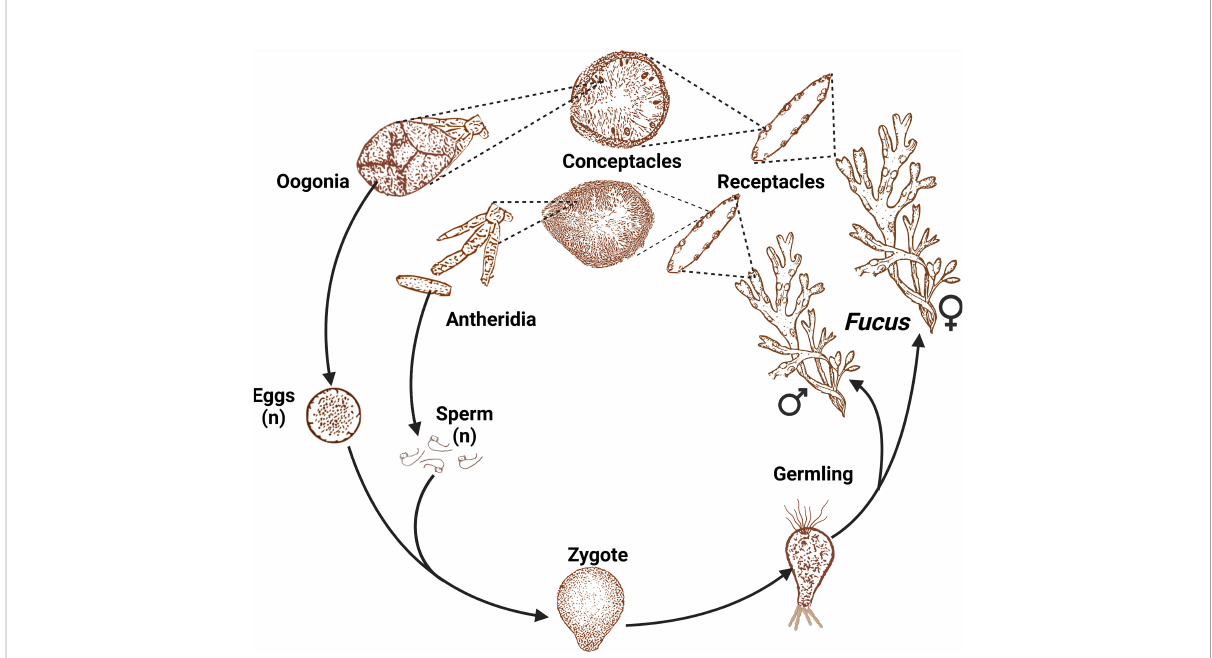
FIGURE 3 Dioecious life cycle of the genus Fucus. A representative illustration, not to scale, adapted from Müller (1991) footage, provided by Technische Informationsbibliothek (TIB) and created with BioRender.com. Receptacles of a hermaphroditic species contain both antheridia and oogonia, whereas in dioecious species (pictured), an individual is either male (all receptacles contain antheridia) or female (all receptacles contain